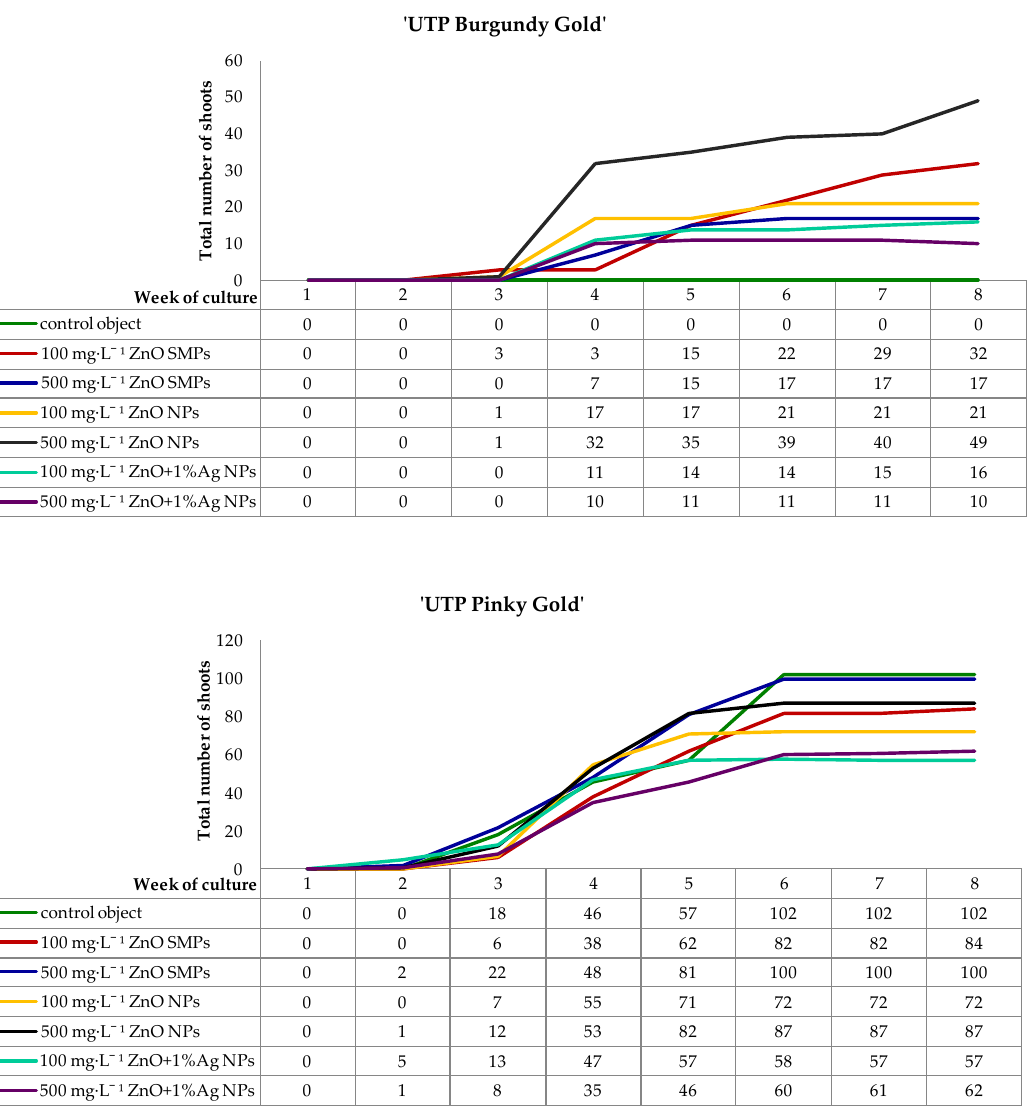
Figure 5. Dynamics of adventitious shoots regeneration on Chrysanthemum × morifolium ‘UTP Burgundy Gold’ and ‘UTP Pinky Gold’ internodes cultured on the modified MS medium with 0.6 mg·L −1 BAP and 2 mg·L −1 IAA, depending on the experimental treatment. Significant differences were found between the two tested chrysanthemum cultivars in terms of their capability for adventitious organogenesis and response to specific ex- perimental treatments (Table 3).